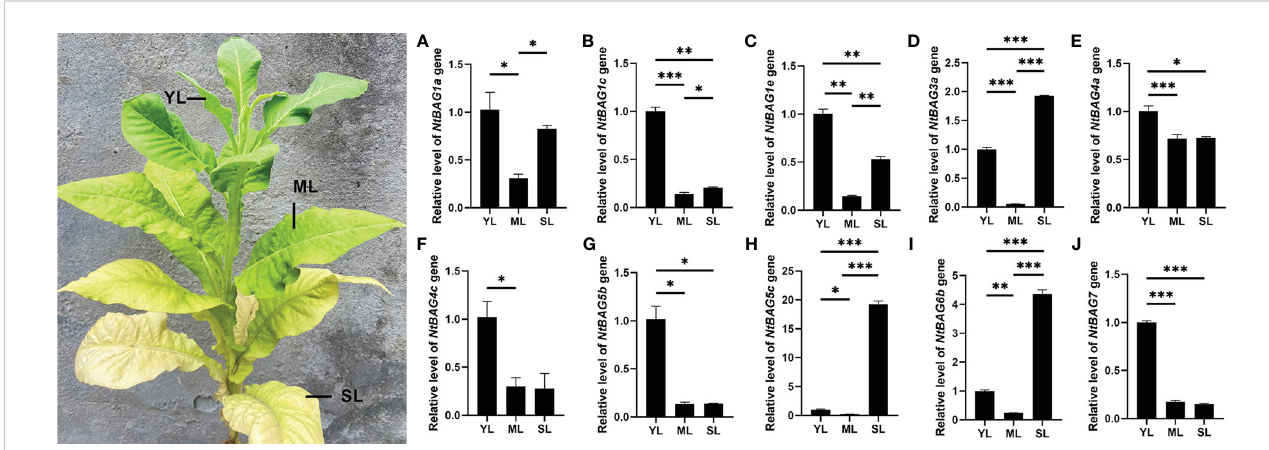
FIGURE 4 The relative expression pattern of NtBAG in wild type tobacco. The expression levels of NtBAG1a (A) , NtBAG1c (B) , NtBAG1e C) , NtBAG3a (D) , NtBAG4a (E) , NtBAG4c (F) , NtBAG5b (G) , NtBAG5c (H) , NtBAG6b (I) and NtBAG7 (J) in plant leaves at different developmental periods, as determined by qRT-PCR. YL, young leaf; ML, mature leaf; SL, senescent leaf. All data are presented as the mean (±SEM) of three independent biological determinations and were analyzed by Student ’ s t -test (* p < 0.05, ** p < 0.01, *** p <